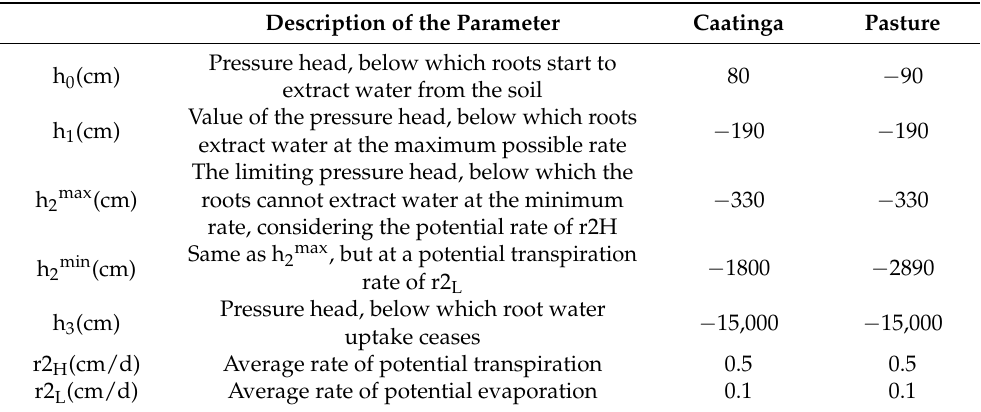
80 − 90 − 190 − 190 − 330 − 330 − 1800 − 2890 − 15,000 − 15,000 0.5